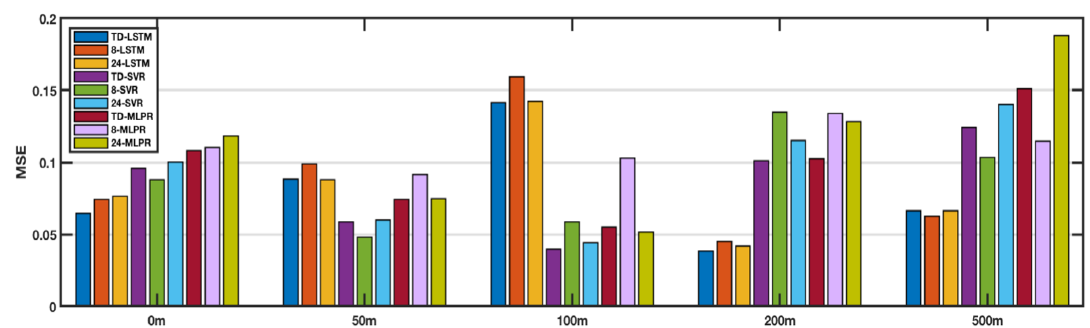
Figure 9. Comparison of performances at different depth in the Equatorial Pacific